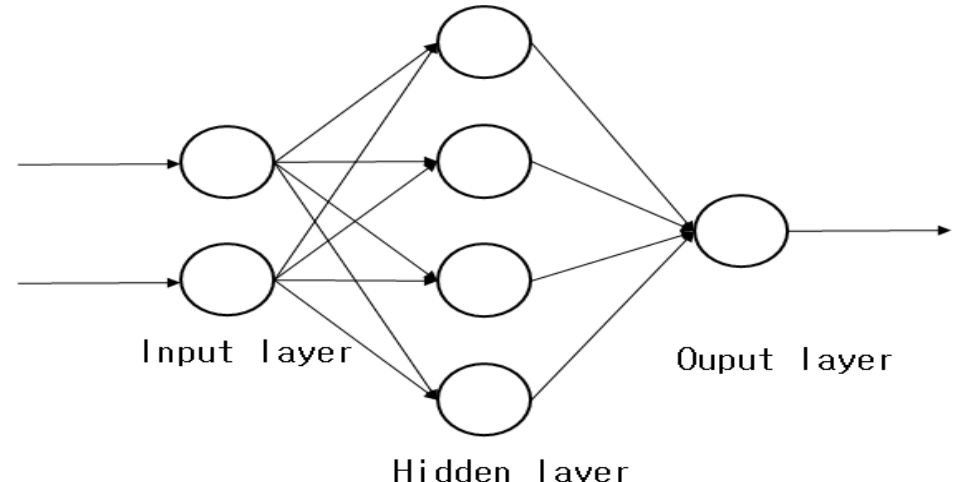
Figure 13. Neural network structure.